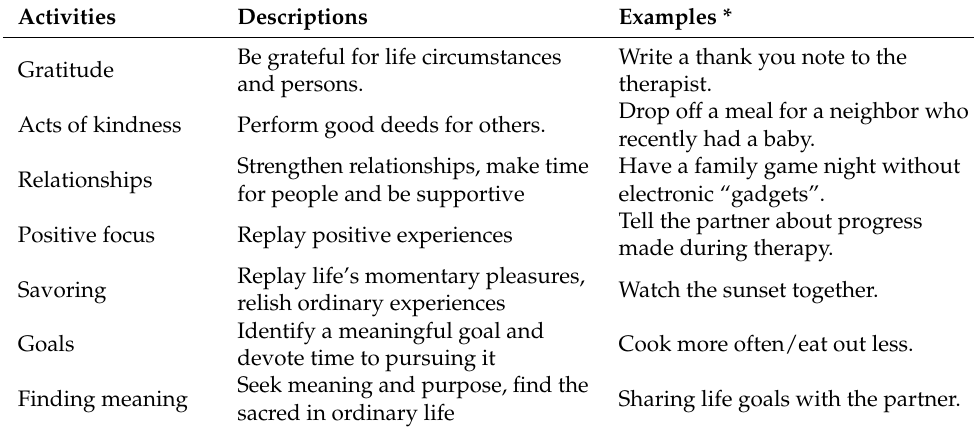
Table 1. ReStoreD activities, descriptions, and